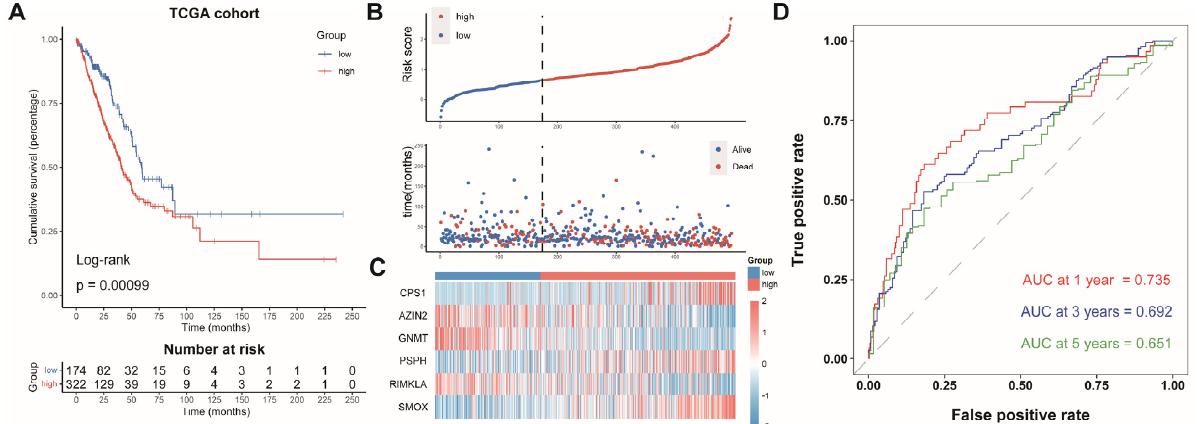
Figure 3. Evaluation and validation of the prognostic value of AAMRGS. ( A ) Kaplan ‒ Meier survival analysis in the TCGA cohort. ( B ) Distribution of risk scores and OS status in the TCGA cohort. ( C ) Heatmap displaying six AAM-related genes in the TCGA cohort. ( D ) Time-dependent ROC analysis in the TCGA cohort.